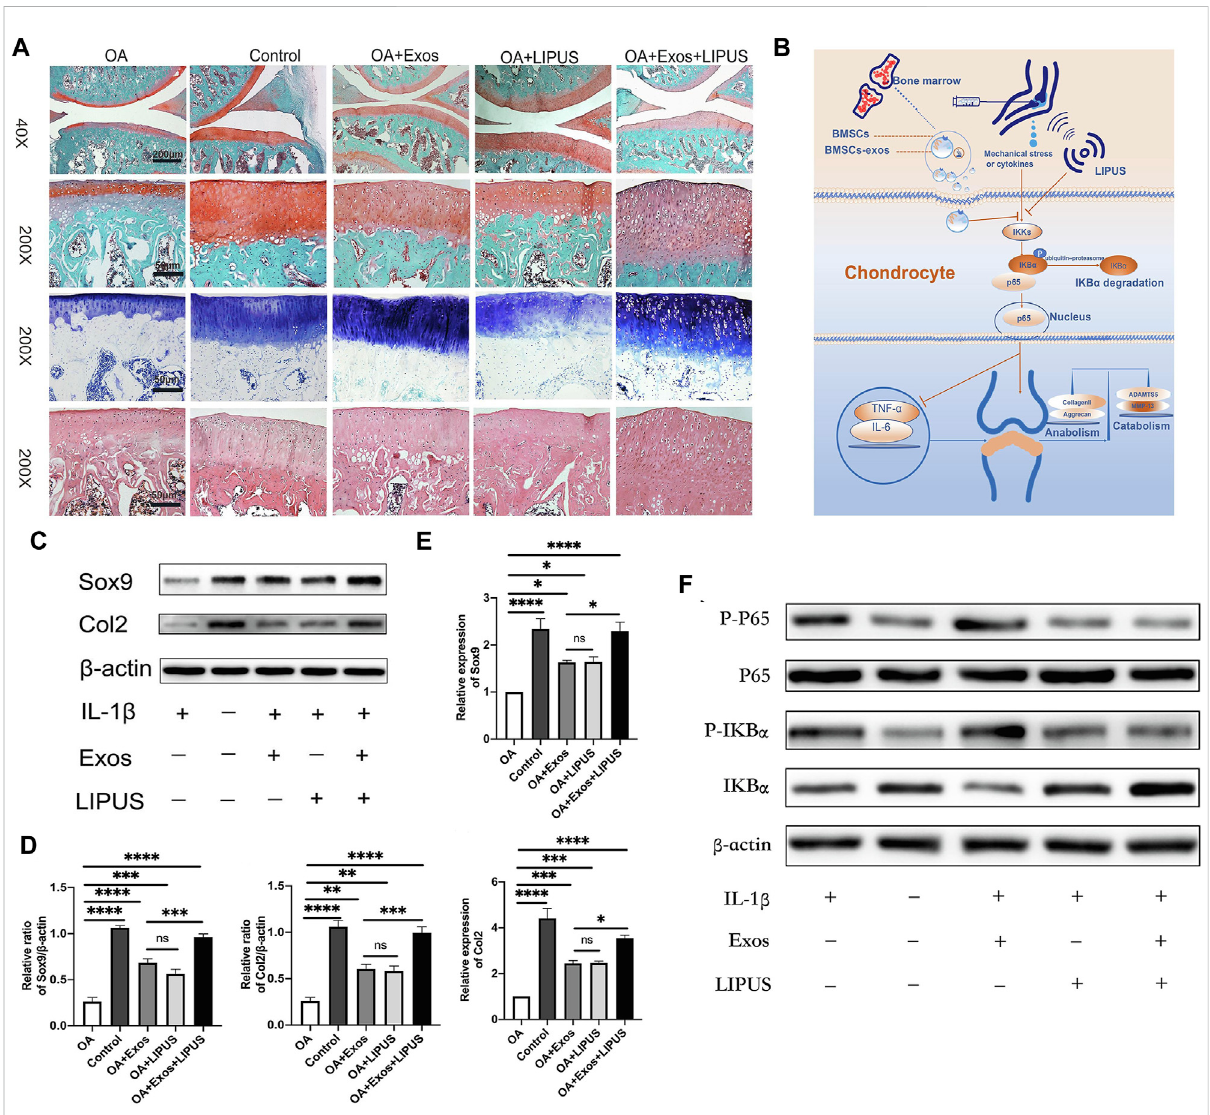
FIGURE 2 Low-intensity pulsed ultrasound (LIPUS) dynamic mechanical stimulus promoted the biological performance of MSC-EVs in OA treatment. (A) Safranin O, Toluidine Blue and HE staining for knee joints sections; (B) The mechanism underlying thetherapeutic effect of LIPUS-treated MSC-EVs; (C,D) Western blot analysis for anabolism related proteins of chondrocytes, and semi-quanti fi cation; (E) RT-qPCR analysis for the expression of anabolism related genes; (F) Western blot analysis for the expression of NF- κ B pathway related proteins. Reproduced from Ref. (Liao et al., 2021), International Immunopharmacology, ELSEVIER Publication at